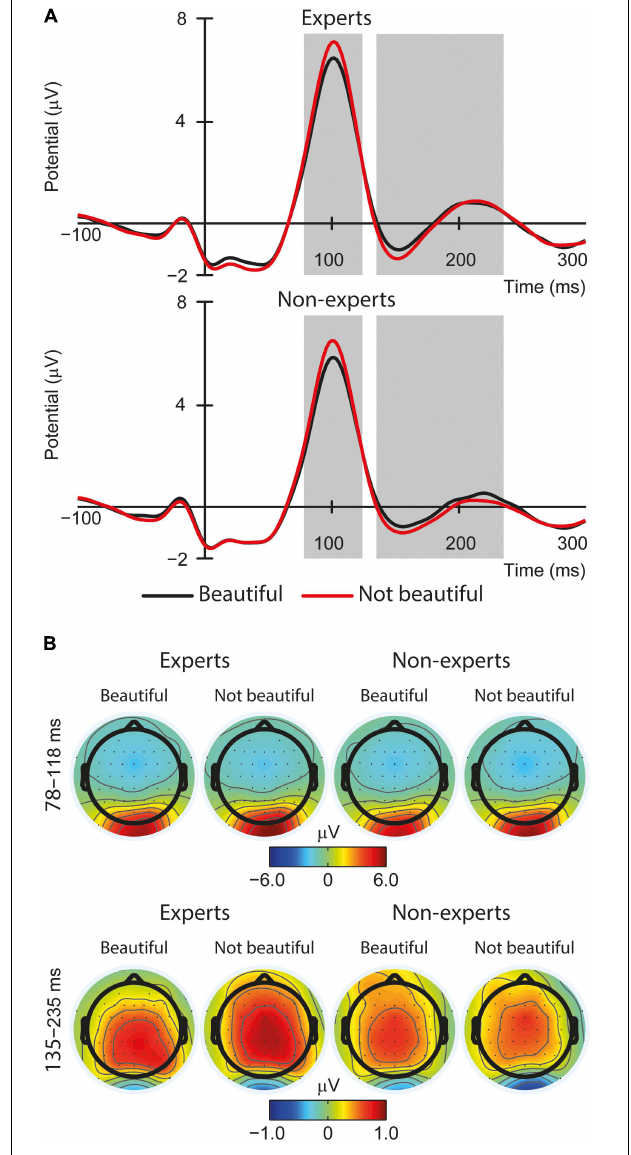
FIGURE 3 | (A) The effect of the aesthetic judgment (beautiful vs. not beautiful) on the lambda response and the N1-P2 complex averaged amplitude from occipital electrodes (O1, Oz, and O2) in the focal mode (EFRPs time windows are indicated by the gray fields). (B) Topographic maps of fixation onset – related brain activity in two-time windows (focal mode): 78–118 ms (lambda response) and 135–235 ms (N1 – P2 complex).